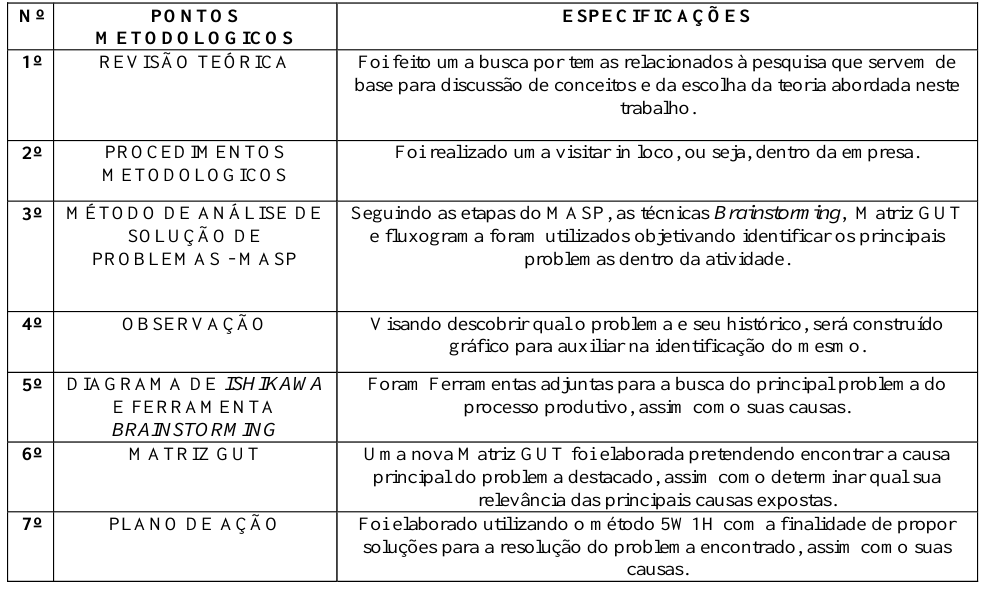
Tabela 3: Especificações de procedimentos utilizados .